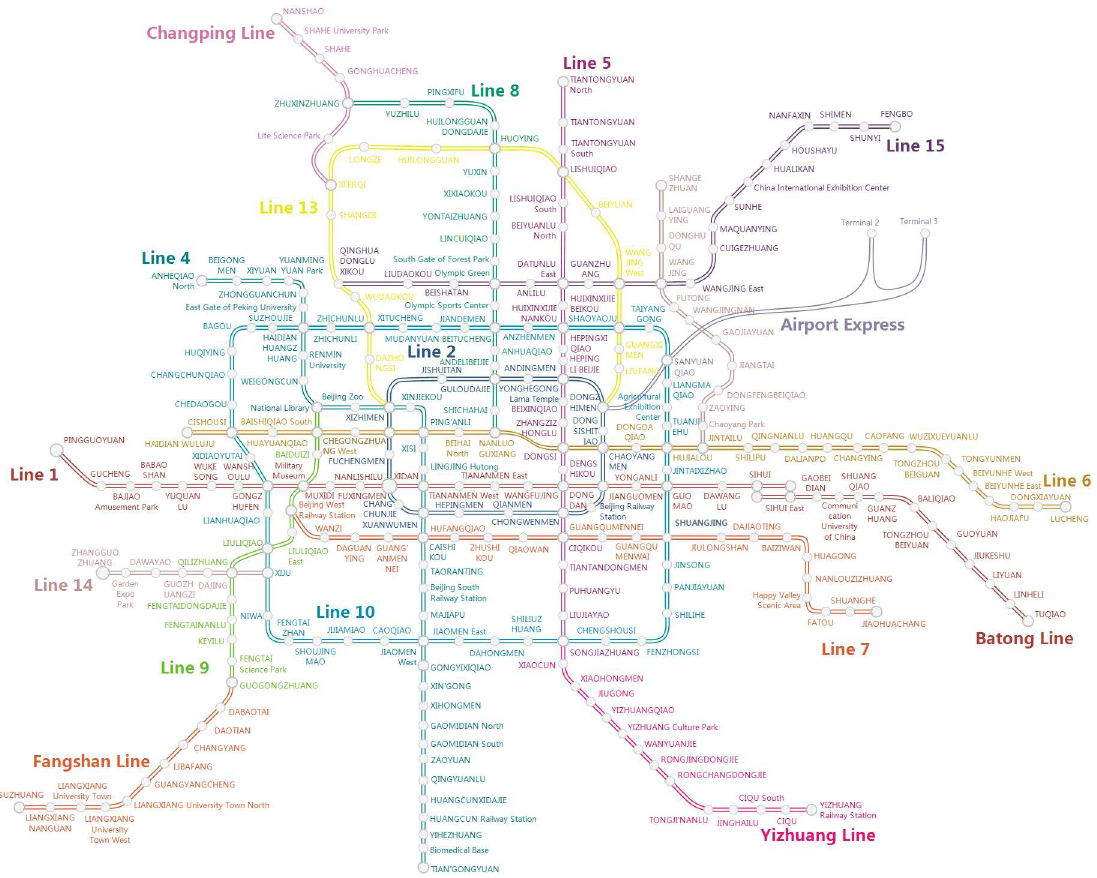
Fig 7. The Beijing rail transit network map for 2015. This map is originallypresentedin this paper by the Haodong Yin , basedon open access data of the Beijingrail transit using our own developed software.